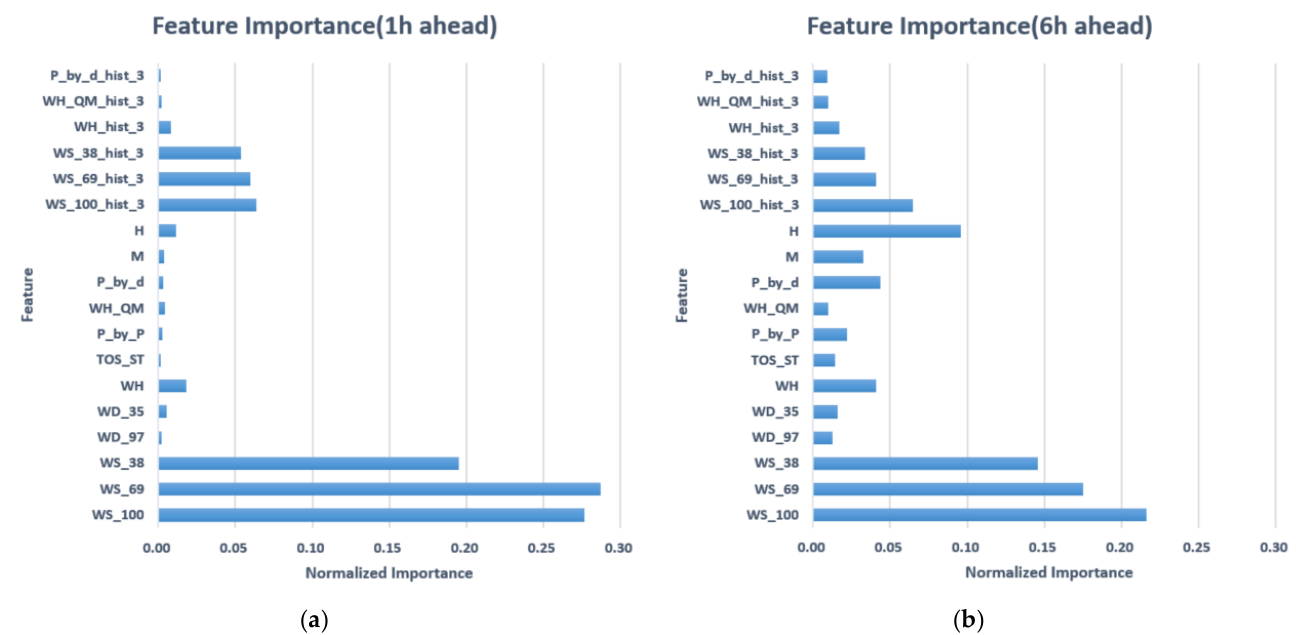
Figure 6. Feature importance of different predicting periods. ( a ) Feature importance of one hour ahead. ( b ) Feature importance of 6 h ahead.